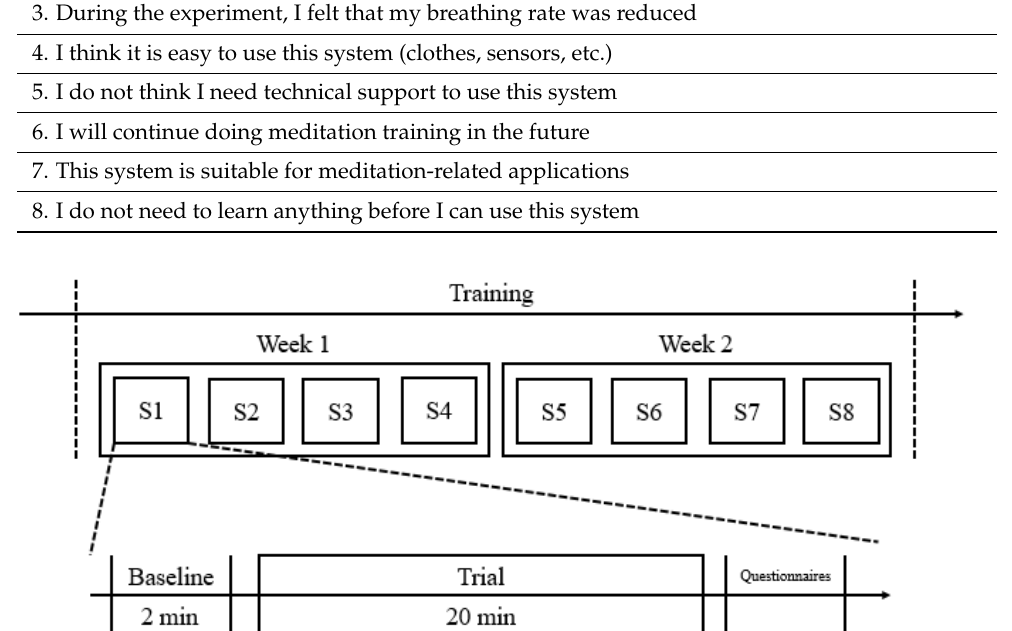
Figure 10. The experiment procedure of our